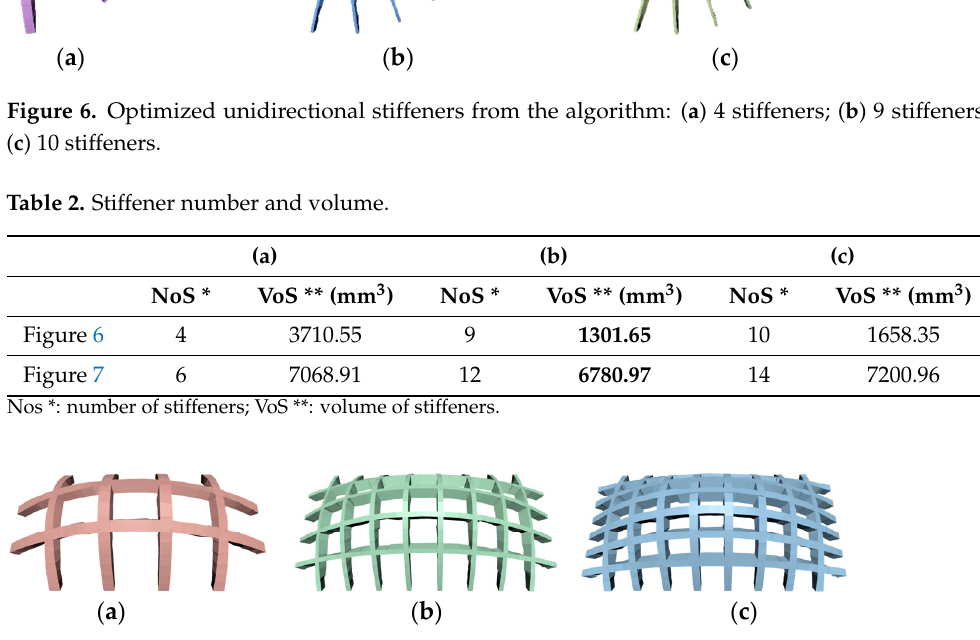
Figure 7. Optimized bidirectional stiffeners from the algorithm: ( a ) 6 stiffeners; ( b ) 12 stiffeners and ( c ) 14 stiffeners